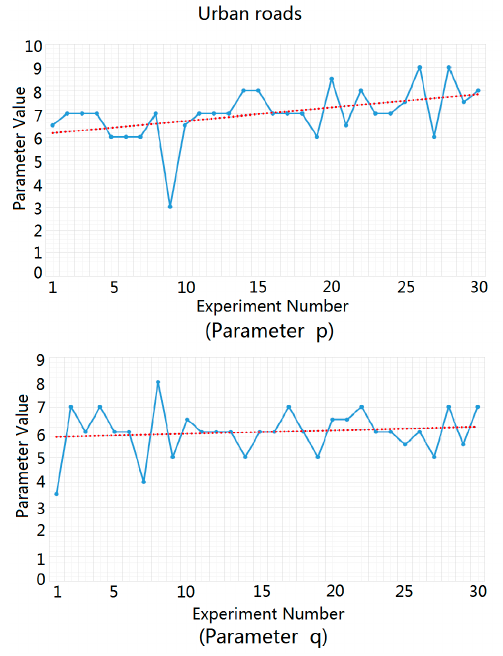
Figure 8. Solution process of parameters 𝑝 and 𝑞 for urban roads.